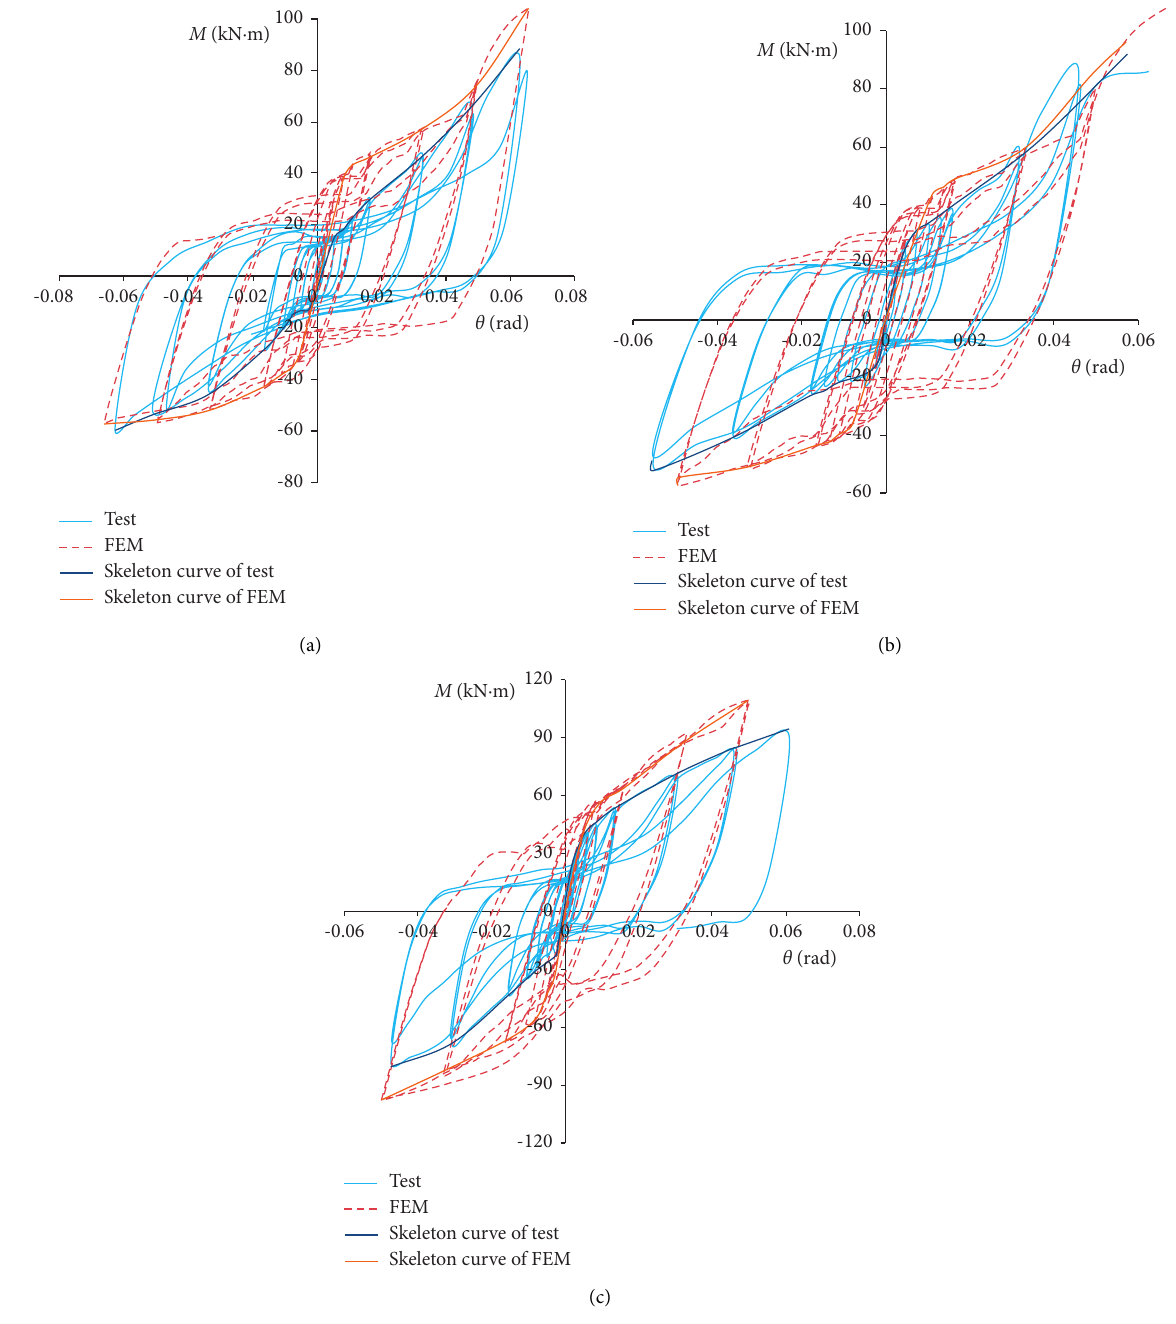
Figure 14: Comparison of moment-angle hysteresis loops. (a) SJB-1. (b) SJB-2. (c) SJB-3. Table 4: Comparison between the SJA experimental and finite element analysis